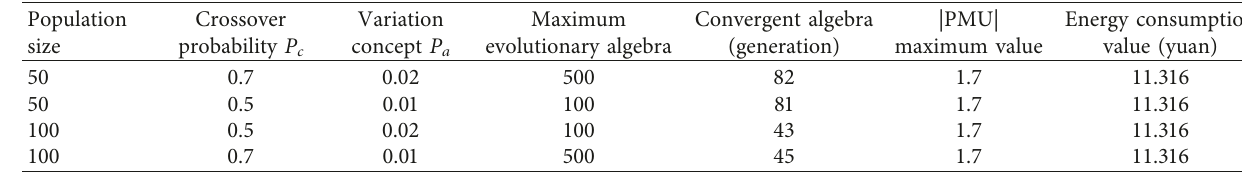
Table 4: Parameter Settings and effects when m � 6 and n �